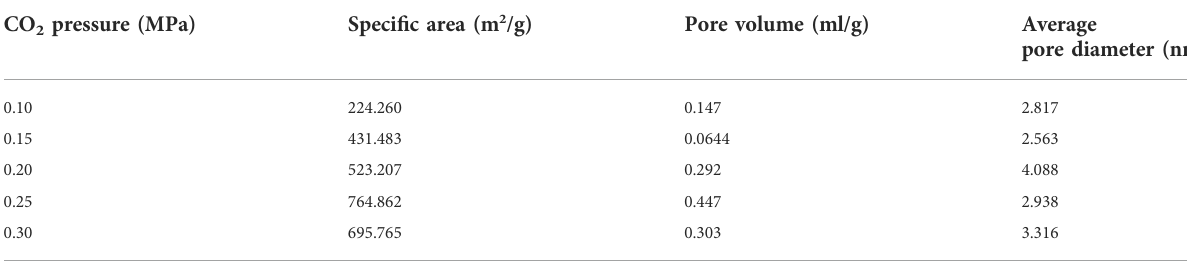
TABLE 1 Surface parameters of the prepared silica gel at different CO 2 pressures.